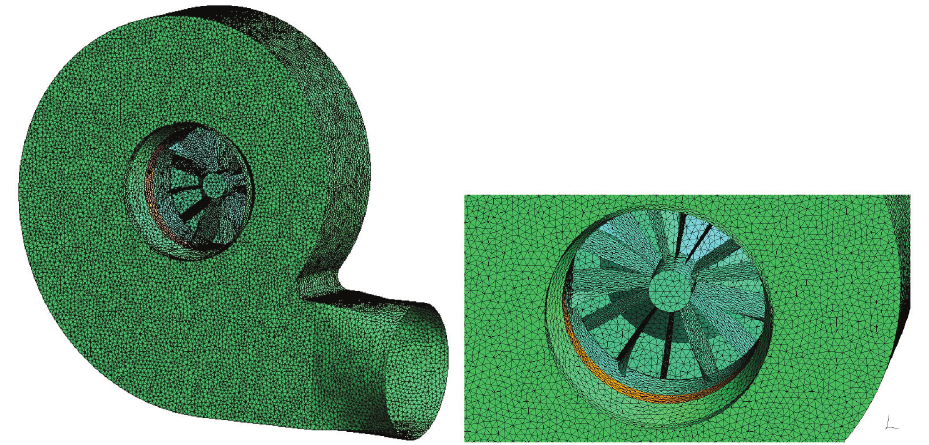
Figure 22 - Three-dimensional views of the fan; surface triangular mesh